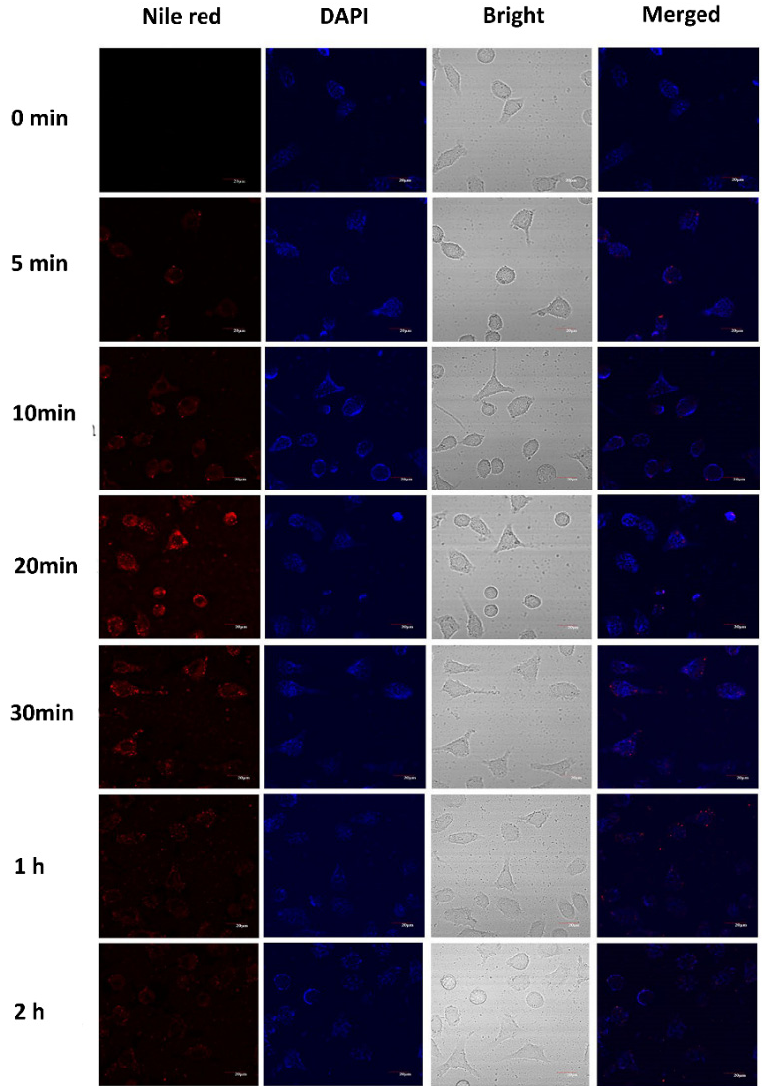
Figure 5. Cellular uptake observed by CLSM of cultured MCF-7 after treatment with CAS-loaded nanoemulsions. Cell nuclei were stained with DAPI for visualization in blue, and nanoemulsions were dyed with Nile red in red.